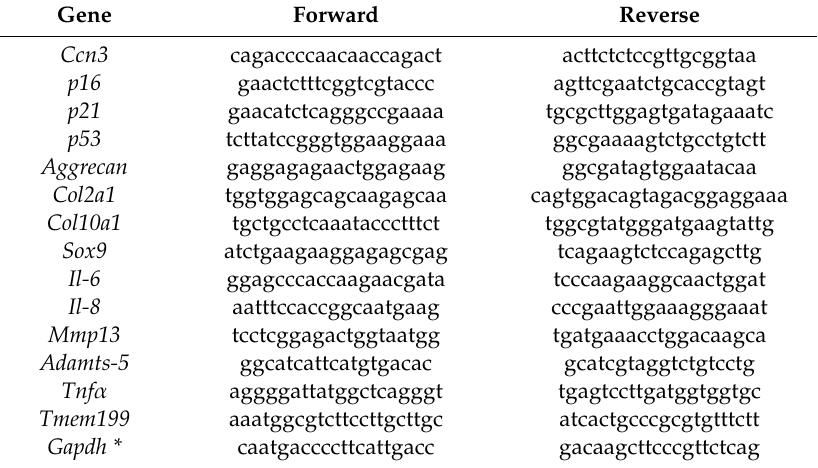
Table 1. Primer sequences for mouse tissues.